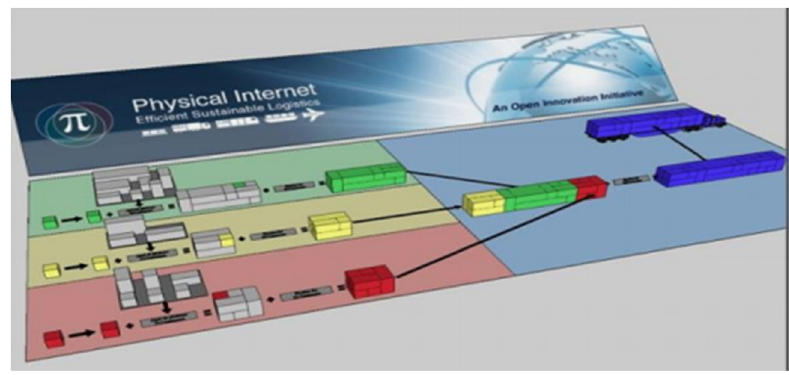
Figure 1: Physical Internet. Source: Woschank and Zsifkovits [ 1 ]